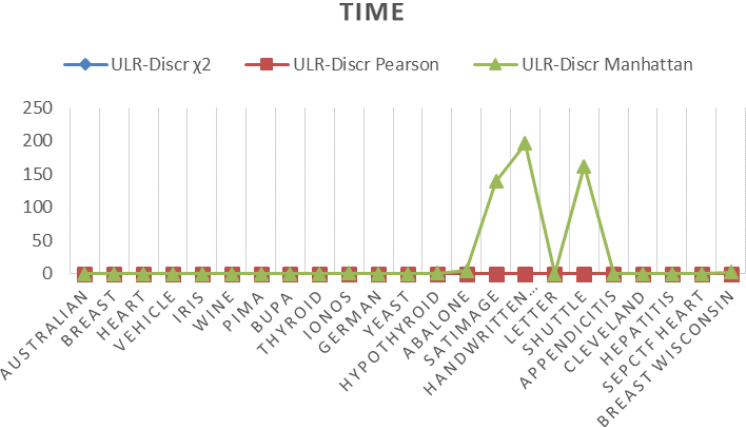
Fig. 5. Comparing runtime for the three variants of ULR-Discr.